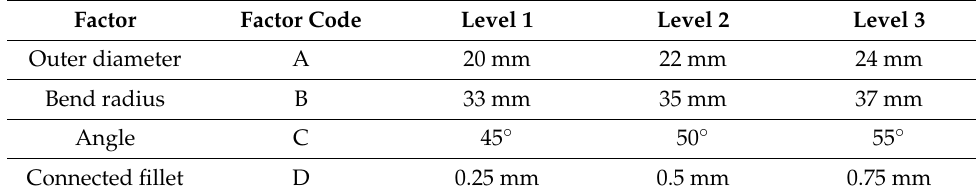
Table 1. Design parameters and